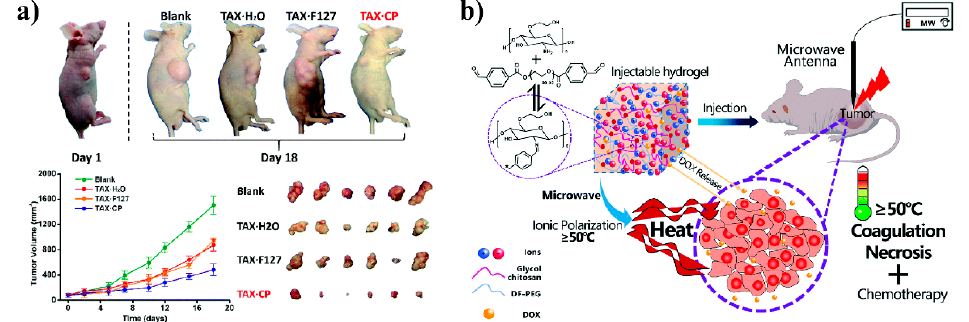
Figure 7. ( a ) The results of the intra-tumor injection experiments. The nude mice were divided into four groups based on different treatments, namely blank group (injection only with saline water), TAX·H 2 O group (injection with Taxol solution), TAX·F127 group (injection with Taxol in pluronic F127 hydrogel) and TAX·CP group (injection with Taxol in CP hydrogel). The bottom part shows the relative tumor volume changes under various treatments. Reprinted with permission [44]. Copyright 2017, Royal Society of Chemistry; and ( b ) a schematic illustration of microwave ablation therapy. The ionic the hydrogel induced a rapid and remarkable temperature increase from room temperature to 50 ◦ C, accompanied by a constant release of DOX. Reprinted with permission [45]. Copyright